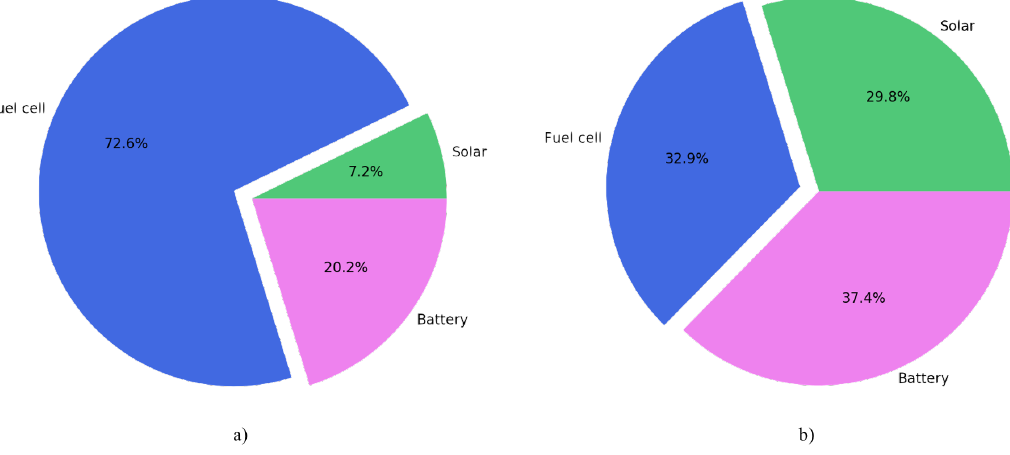
Figure 7. Example of energy usage by power sources for high consumer with priority-based internal agent ( a ) without fuel cell scheduling function and ( b ) with added scheduling